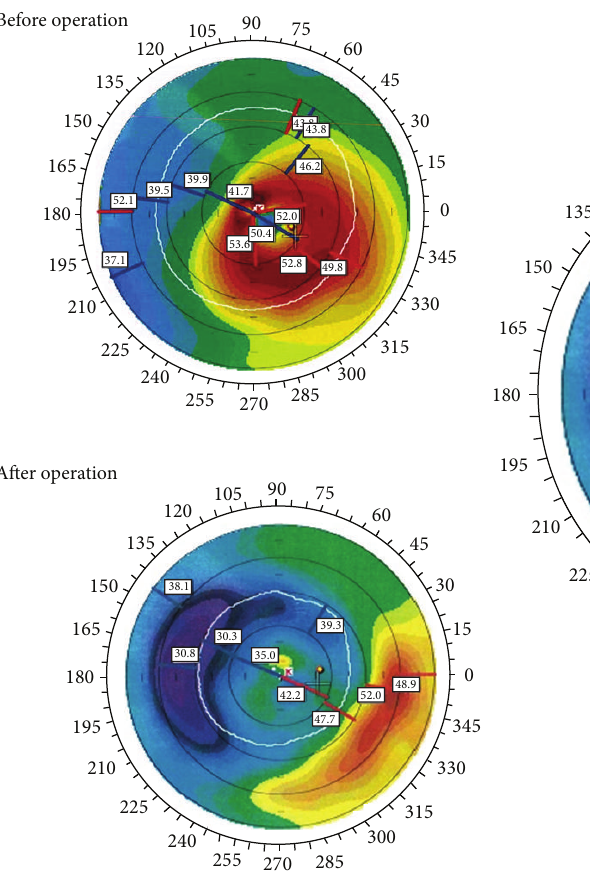
the suggested technique for implantation. However, manual and mechanical techniques are not